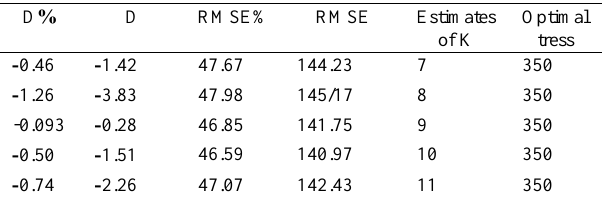
Table. 1: The evaluation of the random forest to determine the most appropriate parameter for volume using the spectral data